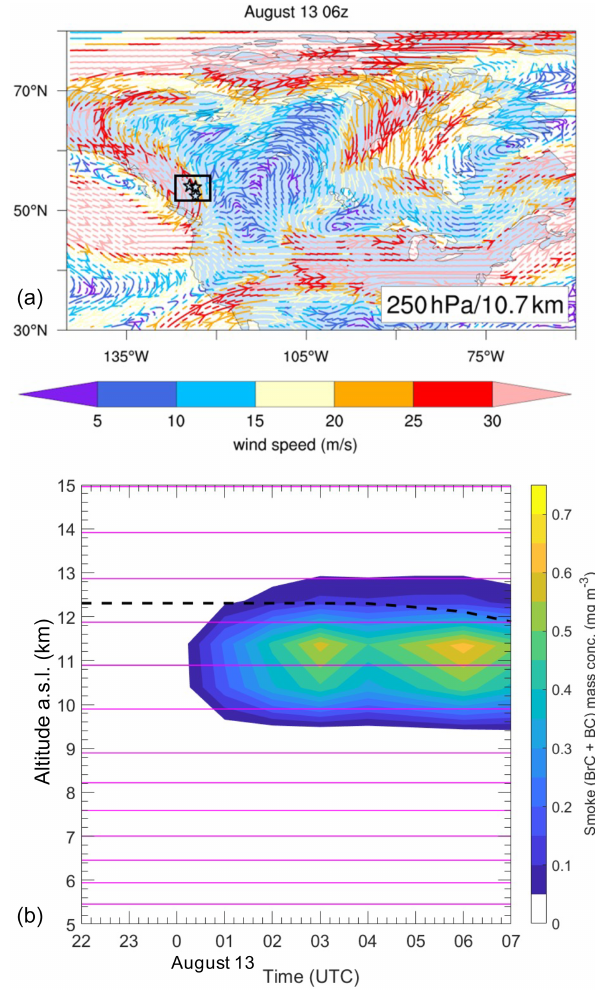
Figure 1. On the day of initial injections. (a) Wind streamlines col- ored by wind speeds on 13 August 2017 at 06:00UTC and 250hPa (or 11km), which is the mean altitude of smoke aerosol injections in the model. The three black markers depict the injection locations. (b) The vertical location of smoke aerosols is depicted using con- tours of simulated aerosol (BC + BrC) mass concentrations, aver- aged over the black box in panel (a) during the injection period between 00:00–06:00UTC on 13 August. The dotted black line de- picts the simulated tropopause heights, and the solid magenta lines depict the edge heights of model vertical